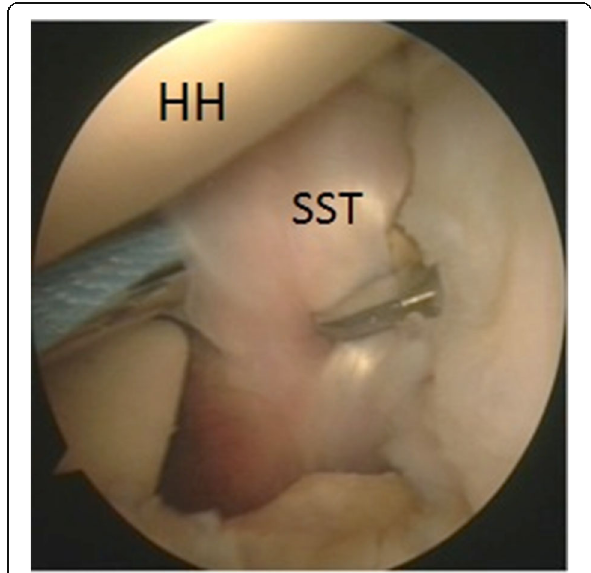
Fig. 7 Left shoulder, anterior on the right and posterior on the left, scope from posterior portal, suture passing device from antero-inferior portal. The upper third of the subscapularis tendon is penetrated with a tape (HH: humeral head, SST: subscapularis tendon)